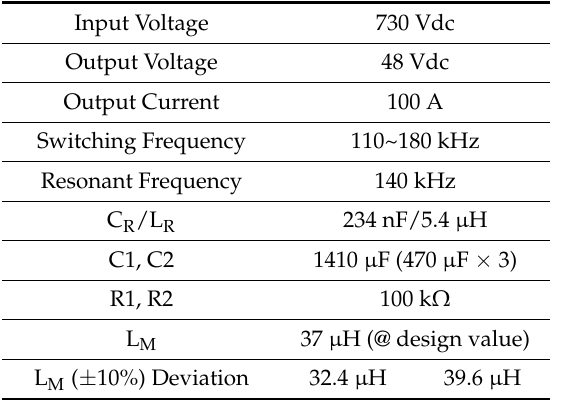
Table 3. Parameters for comparative analysis of DC/DC converters.